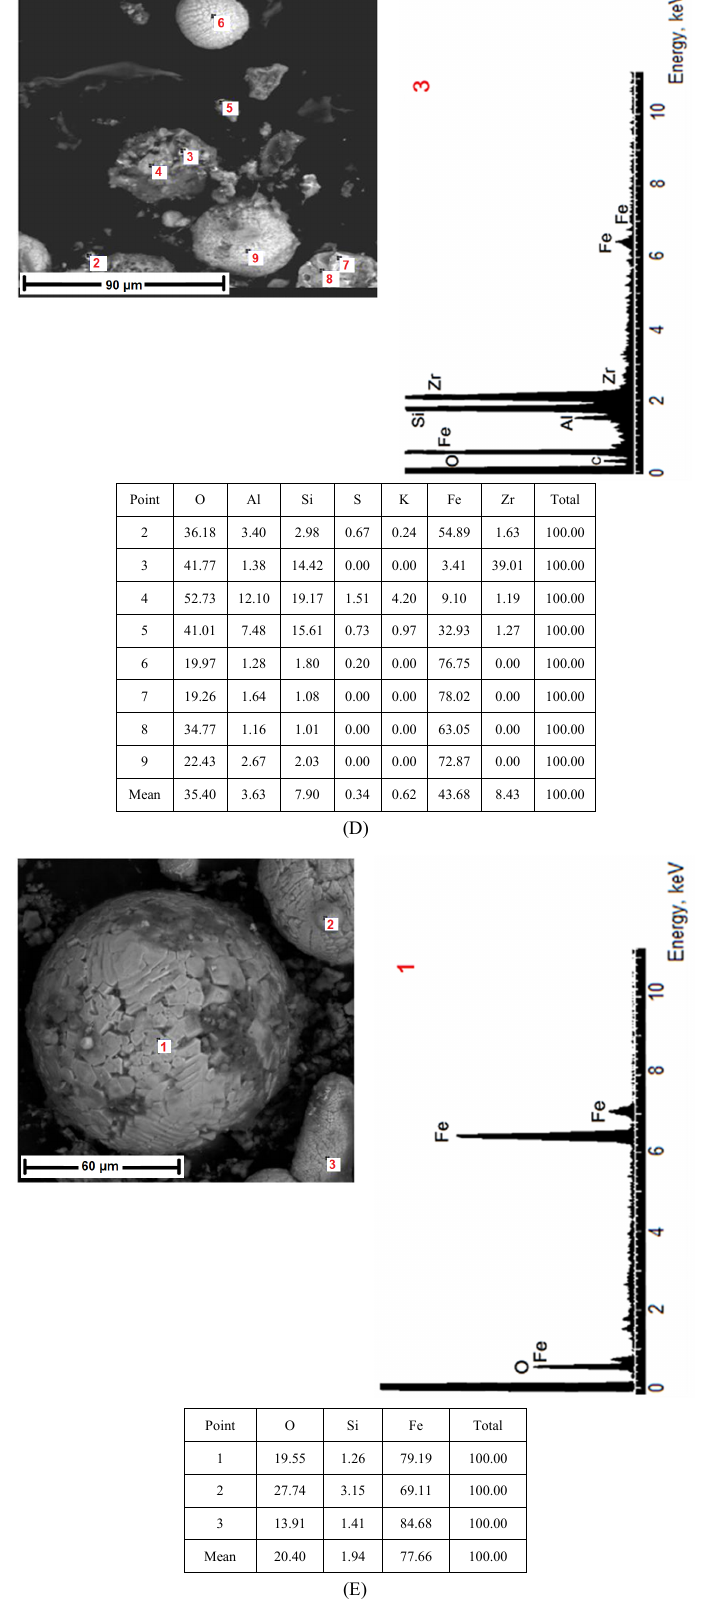
Figure 7. Electron microscopic images and energy dispersive spectra of particles of the magnetic phase of the upper soil horizons of Gubakha (0–10 cm layer): ( A , B )—residential zone; ( C – E )—industrial zone of OAO “Gubakhinsky coke”.